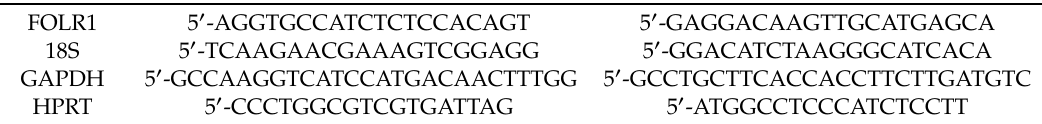
Table 1. List of the primers used for